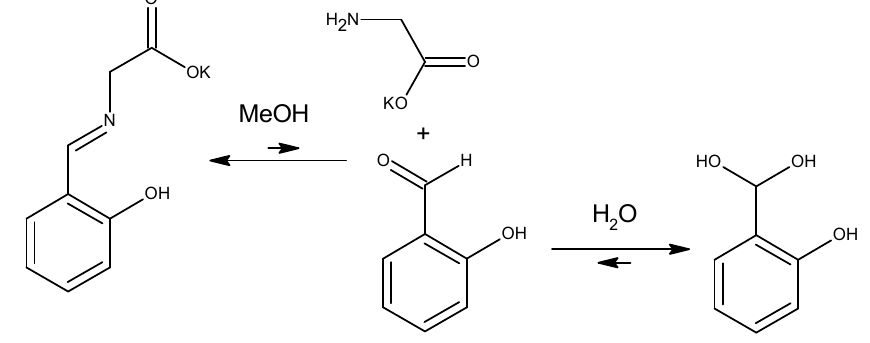
Figure 3. Hydrolysis progress chromatograms of ( A ) reactions of ligand 1 with metal ions, ( B ) ligand water solution. 1 water solution.